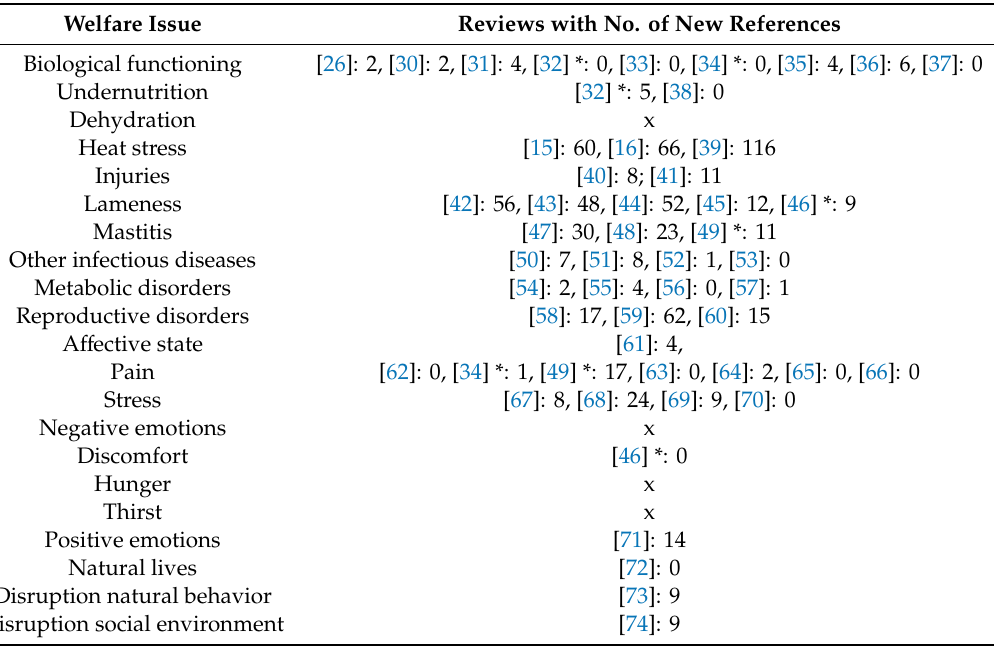
Table 1. References of the reviews that were read for each welfare issue (in brackets). The value after each review refers to the number of new references (i.e., references to articles that were not found in previous reviews; reviews were read in reverse chronological order) they provided as support for associations between indicators and their respective welfare